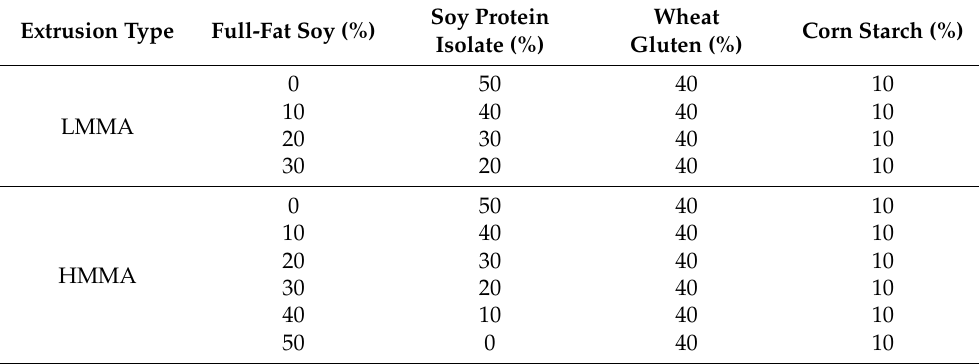
Table 1. Formulation of extruded low- and high-moisture meat analog with different full-fat soy